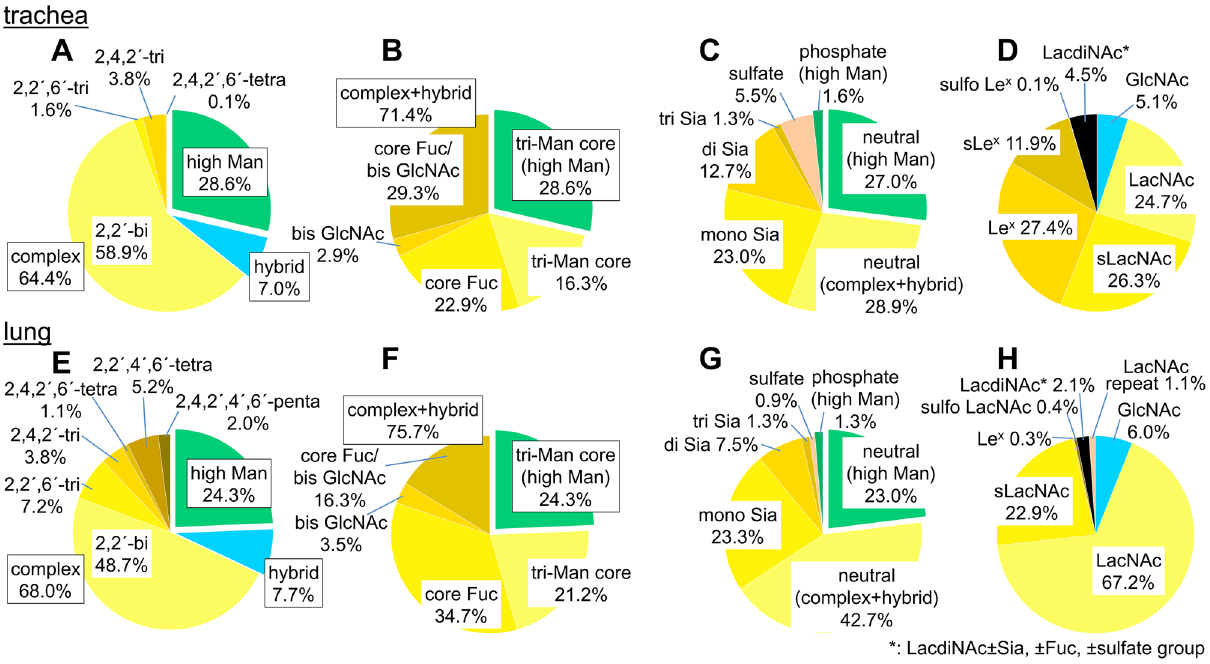
Figure 6. Summary of the structural features of N -glycans from chicken trachea ( A – D ) and lung ( E – H ). ( A , E ) Relative abundance of high mannose, hybrid, and complex-type N -glycans, categorized by branching pattern (Supplementary Fig. S3). ( B , F ) Relative abundance of N -glycans, categorized by core structures. ( C , G ) Relative abundance of neutral, sialylated, sulfated, and phosphorylated N -glycans in chicken trachea and lung. Sulfated glycan groups include those with simultaneously sialylated glycans, whereas sialylated glycan groups do not include any sulfated glycans. Each value (%) in A – C and E – G is expressed relative to the total amount of PA- N -glycans (= 100%) in Supplementary Table S1. ( D , H ) Relative abundance of characteristic branch sequences on complex or hybrid-type glycans, expressed relative to the total amount of GlcNAc/LacNAc/ LacdiNAc-containing branches (= 100%) in all PA- N -glycans in Supplementary Table S1. Each group of GlcNAc (excluding bisecting GlcNAc), LacNAc, sialyl LacNAc (sLacNAc), Le x , and sLe x includes the corresponding branches located at the non-reducing termini of complex- and hybrid-type N -glycans. Each group of sulfated LacNAc (sulfo LacNAc), LacdiNAc (including sulfo LacdiNAc and sulfo fucosyl LacdiNAc), and LacNAc repeats includes both sialylated and non-sialylated branch